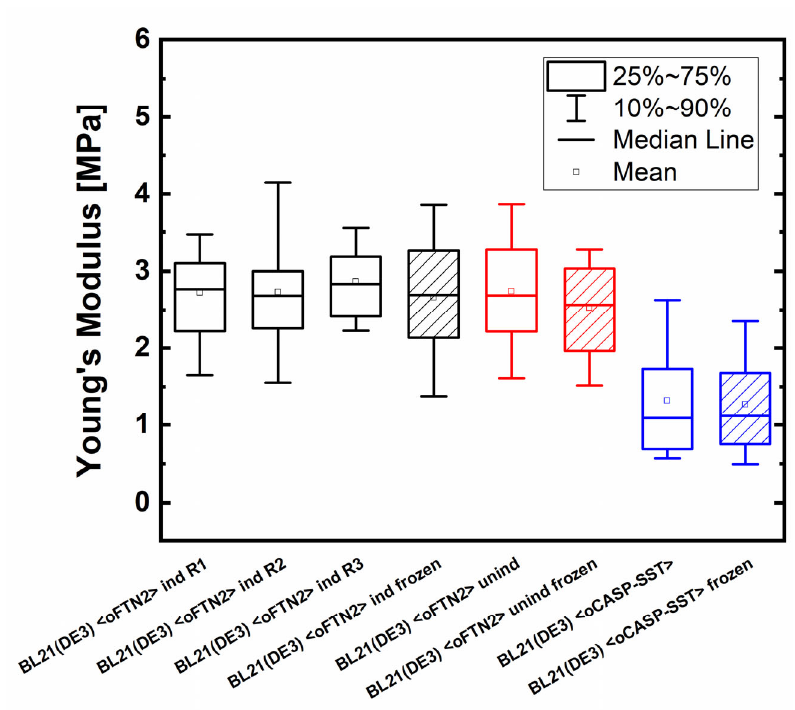
Figure 1. Young’s modulus comparison of freshly harvested or frozen/thawed BL21(DE3) <oFTN2> samples and BL21(DE3) <oCASP-SST. The number of measured cells was 50, 27, 26, 30, 49, 61, 52, and 39 respectively. Black boxes: induced BL21(DE3) <oFTN2> cells, red boxes: uninduced BL21(DE3) <oFTN2> cells, blue boxes: induced BL21(DE3) <oCASP ‐ SST> cells.